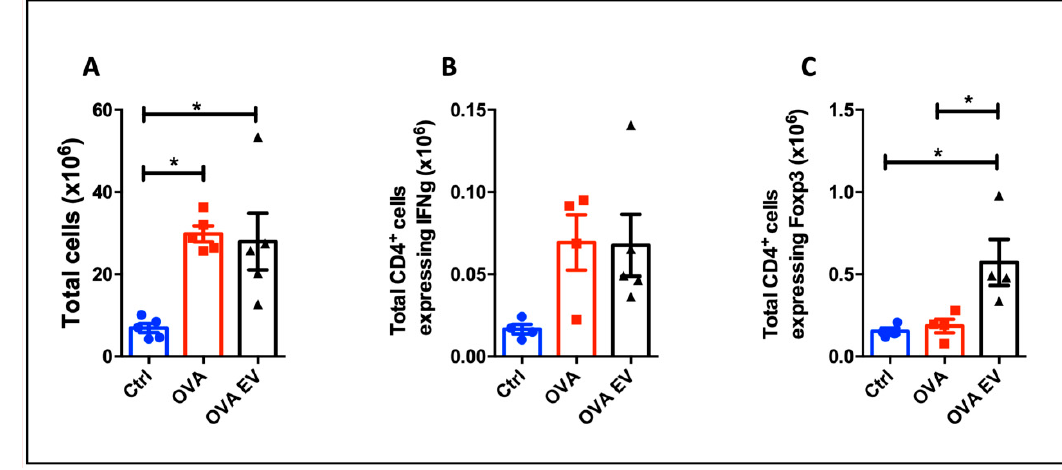
Figure 10. Effects of MSC-EVs in vivo: C57Bl/6 mice were immunized with OVA and treated with MSC-EVs. After 7 days, the animals were euthanized, and the draining lymph nodes were collected. The total number of cells in the lymph nodes ( A ) and the total number of CD4 cells producing IFN- γ ( B ) and expressing Foxp3 ( C ) were evaluated. n = 5 (* p < 0.05).